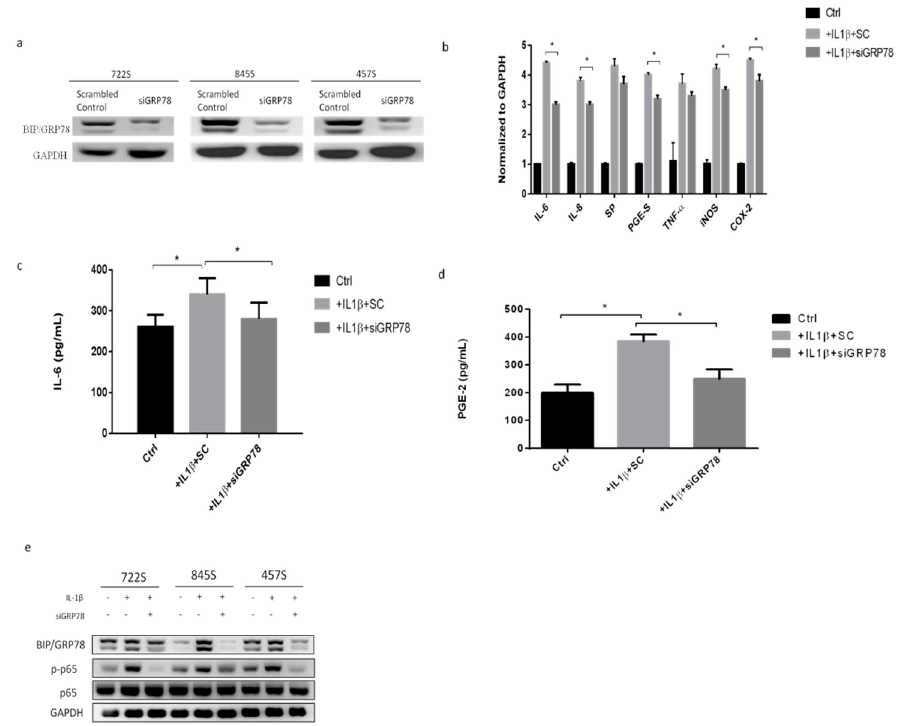
Figure 3. Knockdown of GRP78 decreased inflammatory factors and associated inflammatory sig- naling, using knockdown GRP78 in IL − 1 β (10 ng/mL) treated synoviocytes. ( a ) GRP78 knockdown